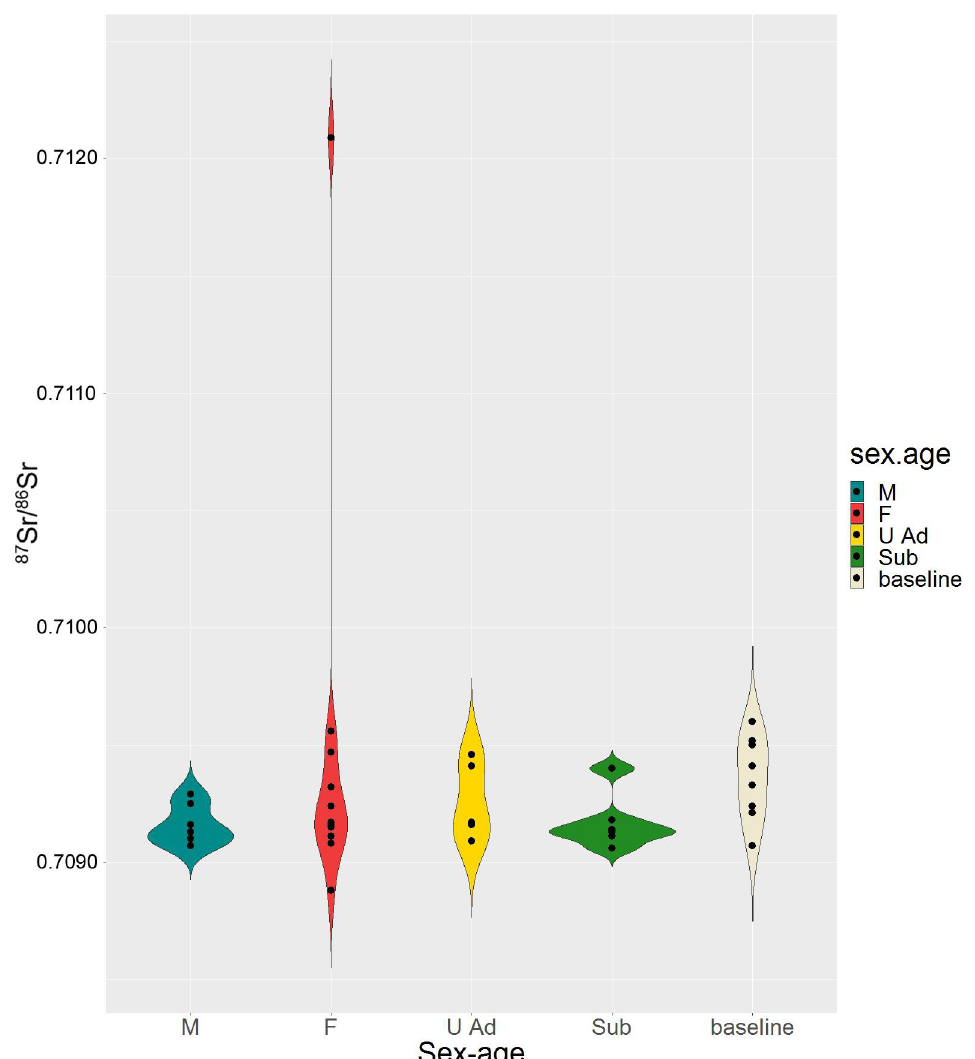
Fig 8. Violin plot. Distribution of the 87 Sr/ 86 Sr values of adult males (M), females (F), adults of undetermined sex (U Ad) and subadults compared with local baselines at Szigetszentmiklo´s.